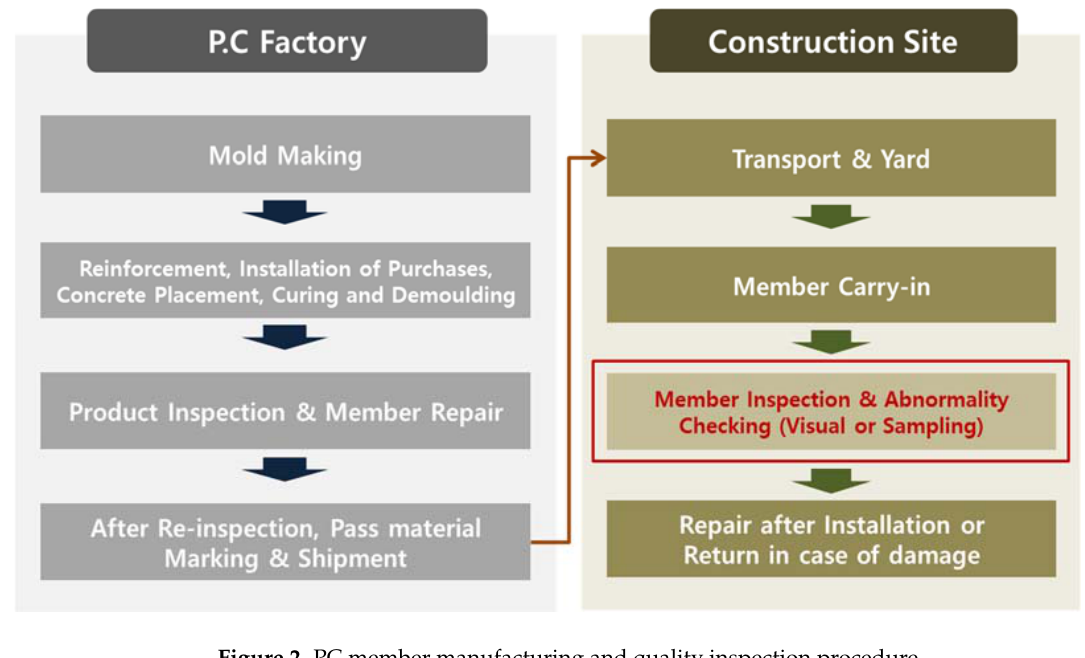
Figure 2. PC member manufacturing and quality inspection procedure.